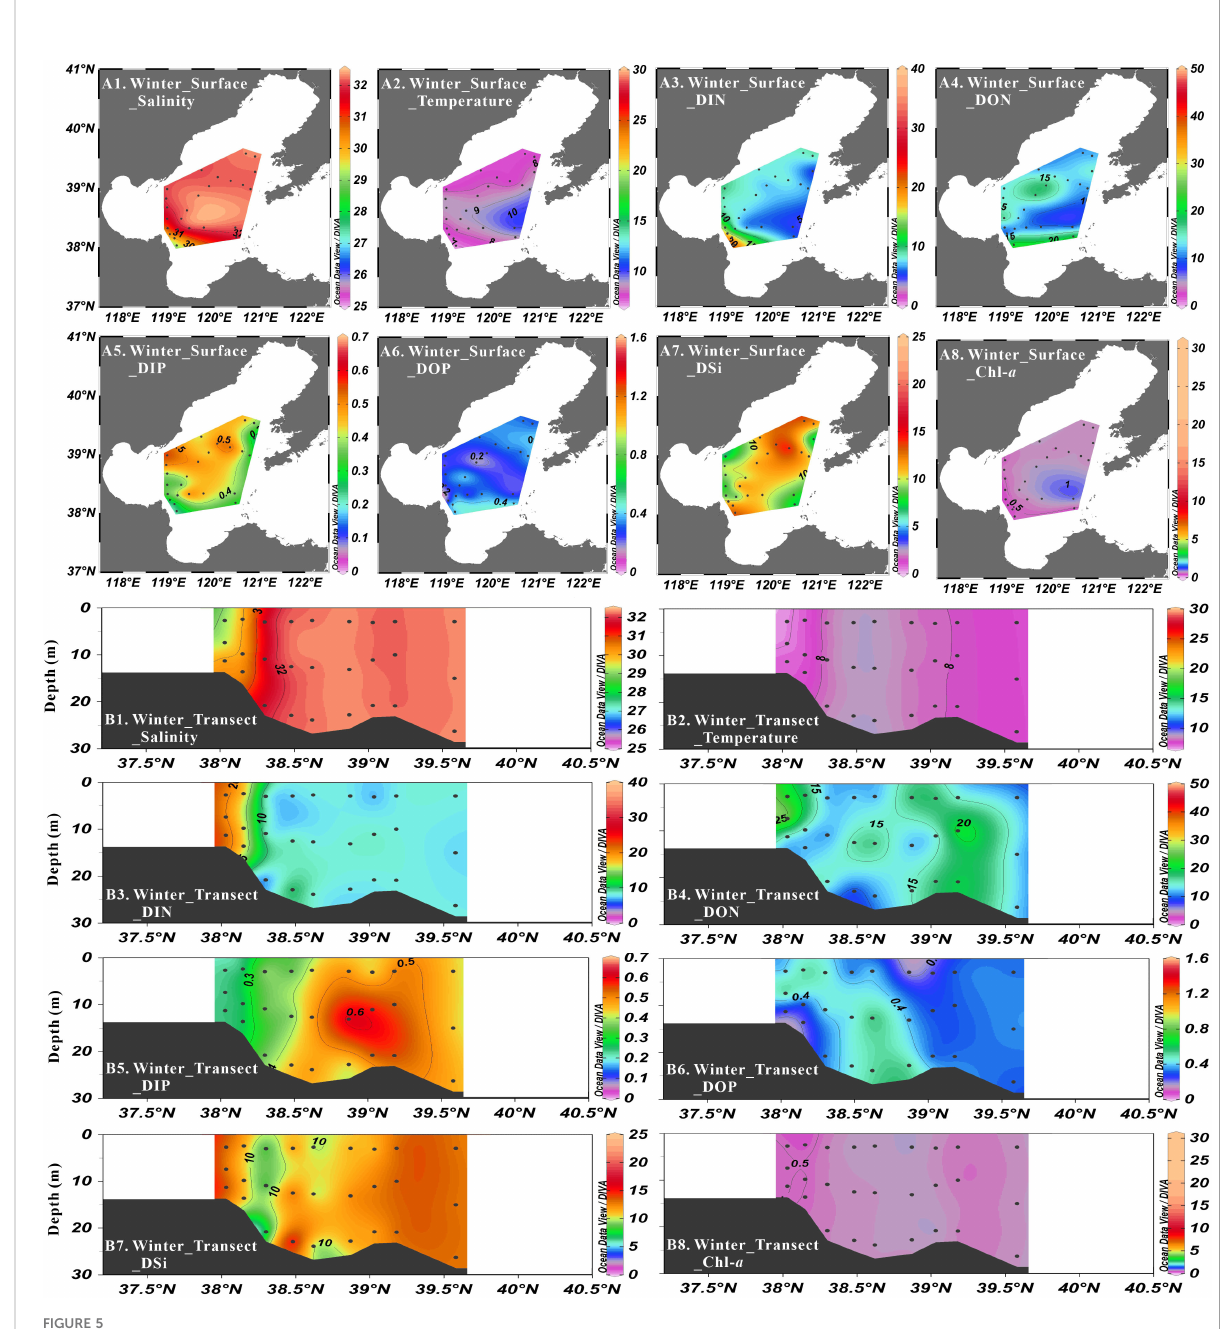
transect (B1-B8) in